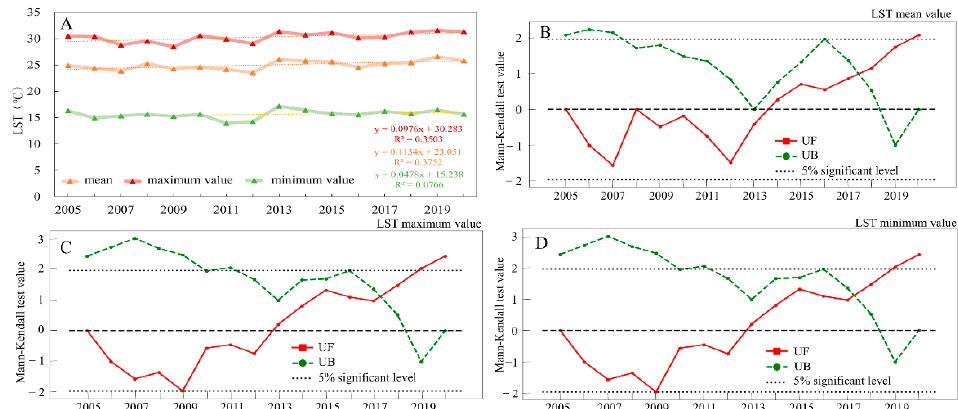
Figure 3. Variation of LST in Zhengzhou from 2005 to 2020 and M–K test values: ( A ) interannual variation; ( B ) M–K mean; ( C ) M–K maximum; ( D ) M–K minimum (yellow: mean, red: maximum, green: minimum).